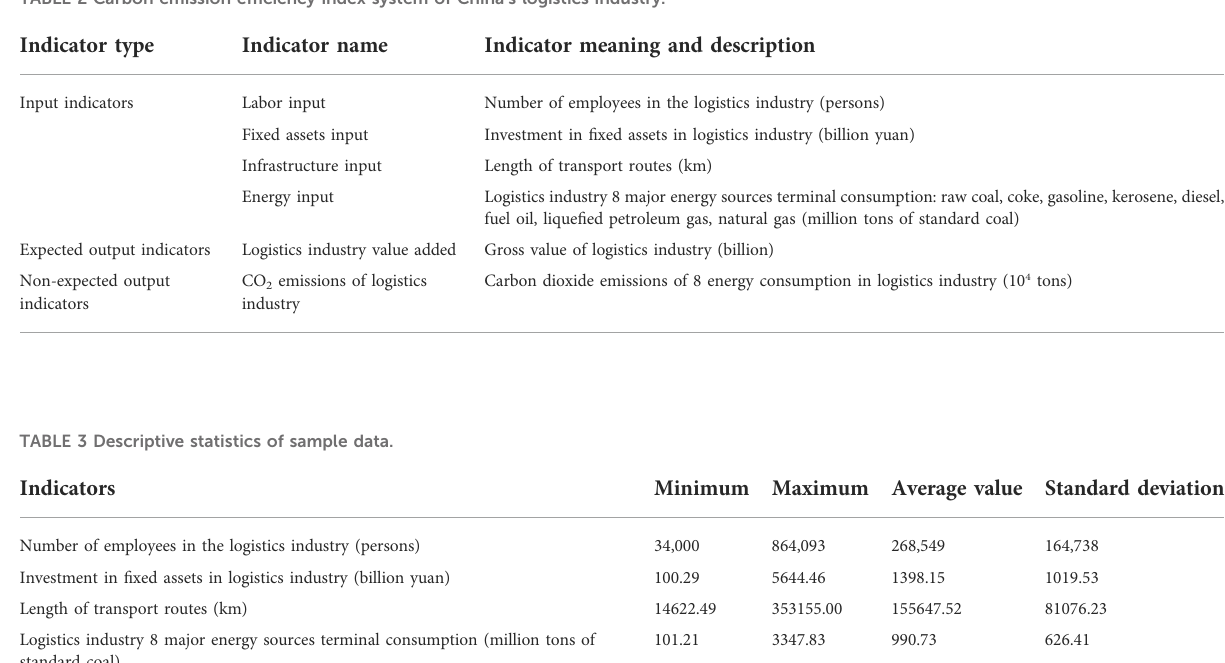
TABLE 2 Carbon emission ef fi ciency index system of China ’ s logistics industry.